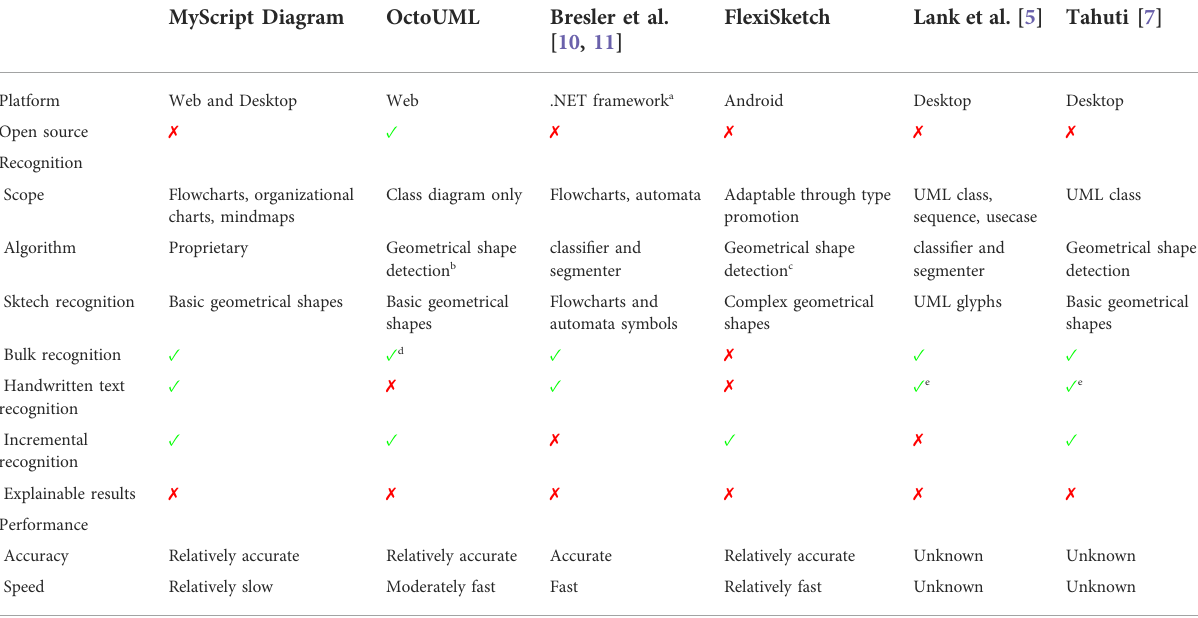
TABLE 2 Existing approaches for natural